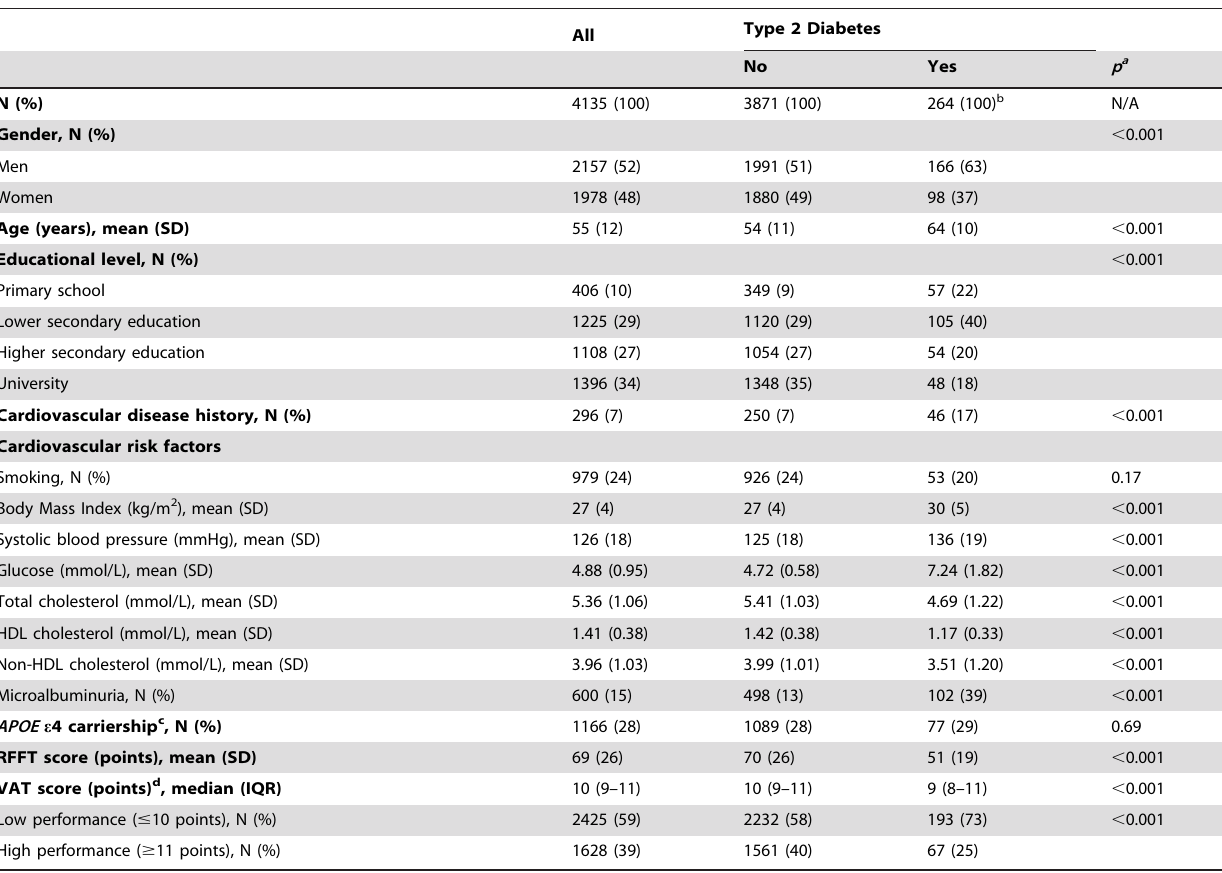
Table 1. Characteristics of the study